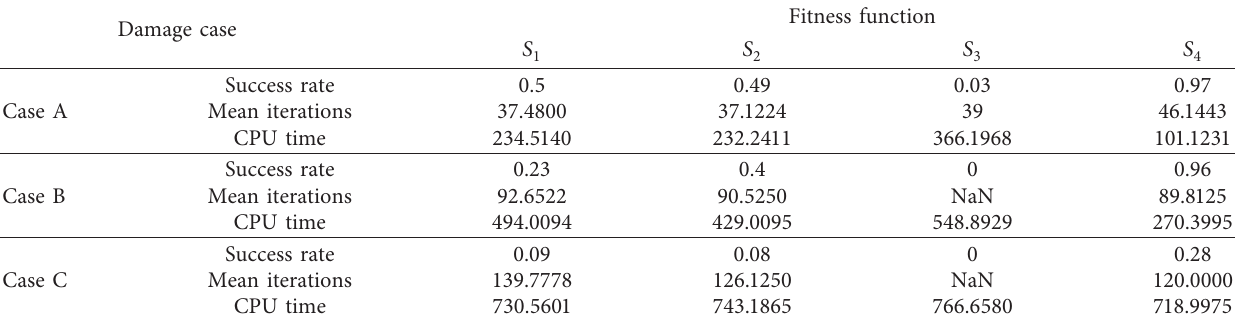
Table 3: Evaluation of the performances of four fitness functions for three defect